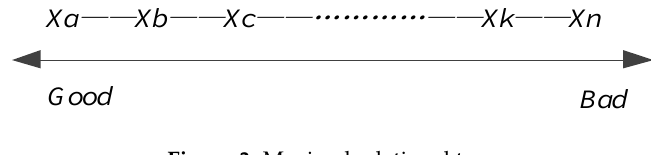
Figure 3. Maximal relational tree.